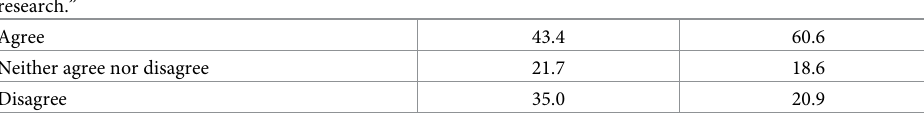
composite score indicates for each respondent the overall extent of their acceptance of research pain/distress justifiability across all purposes and species. Cronbach’s Alpha for the composite PD scale approached 1, indicating good reliability. Exploratory factor analysis suggested 3-fac- tor solutions (Table 6; S1 and S2 Tables). Based on orthogonal varimax rotation, the three fac- tors together accounted for about 90% of the variance. For students, factor 1 was related to the species categories pigs and sheep, monkeys, and dogs and cats for all purposes. Factor 2 was related to small fish, rats and mice, and pigs and sheep for all purposes except chemicals and cosmetics. Factor 3 was related to chemicals and cosmetics for all species. Faculty showed a similar pattern, except factors 1 and 2 were reversed in order, which means faculty displayed slightly more variation compared to students in responses to purposes other than chemicals and cosmetics than they did to pigs and sheep, monkeys, and dogs and cats. These findings